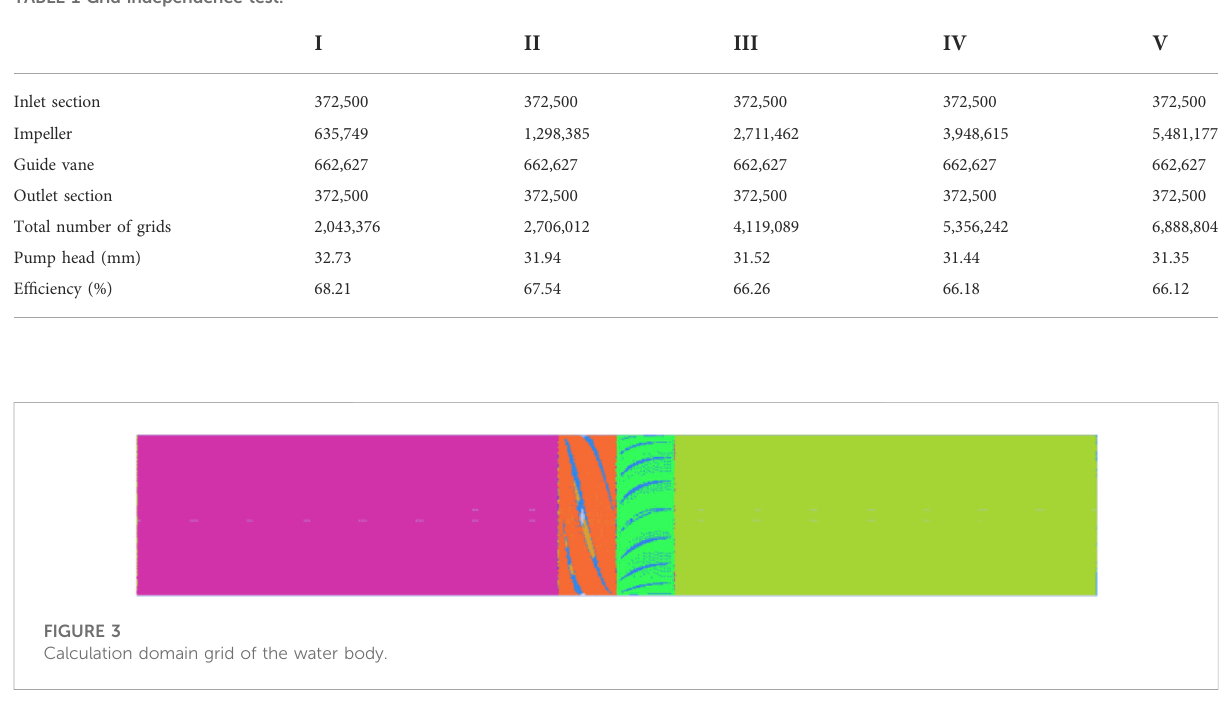
TABLE 1 Grid independence test.